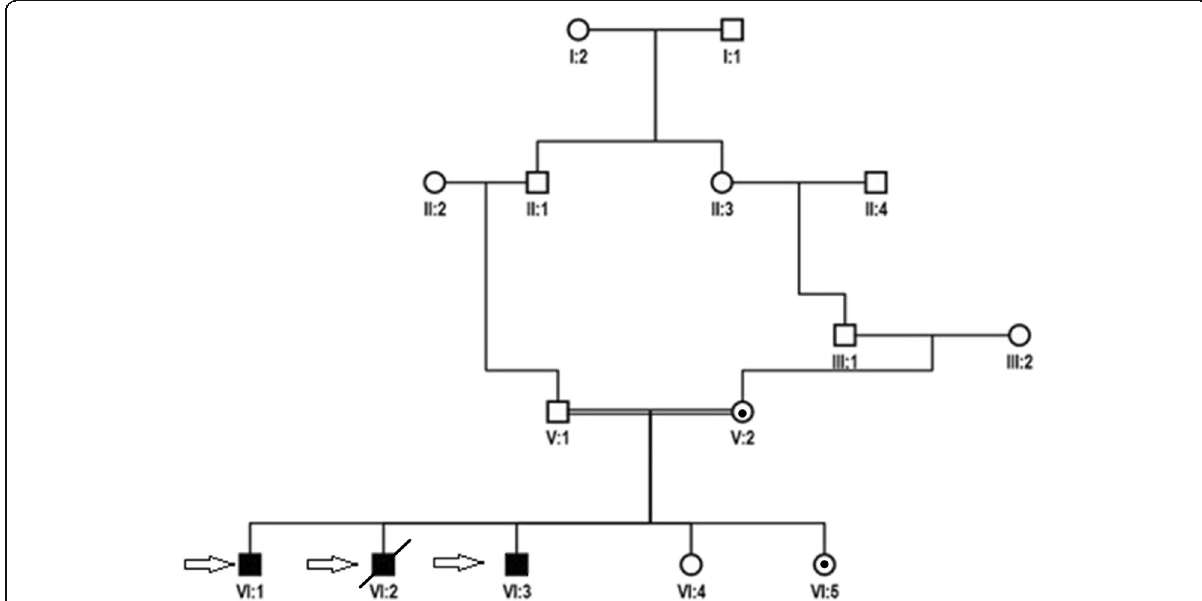
Fig. 1 Family pedigree and Sanger sequencing confirmation of the novel c.905C > T SNV variant. Black symbols represent affected individuals. The index patients are indicated with an arrow. Dot inside the circle indicates